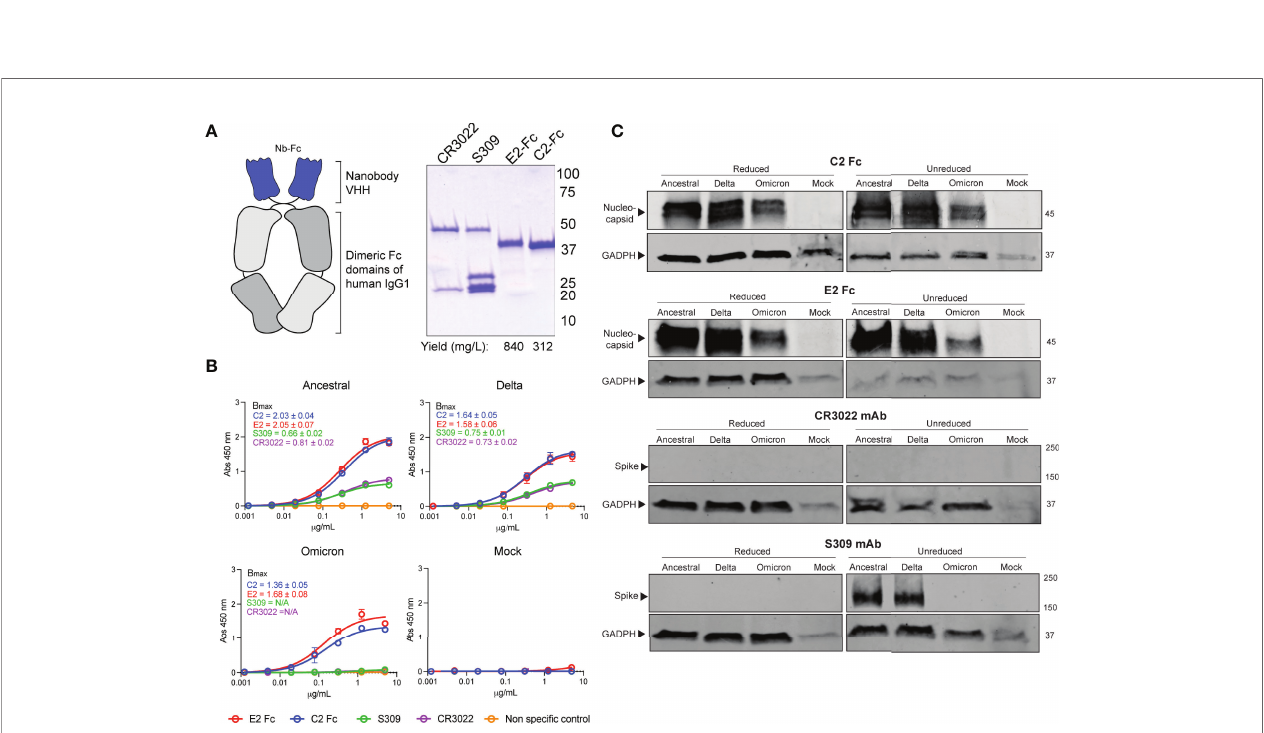
FIGURE 2 | Detection of SARS-CoV-2 variants by N-speci fi c nanobodies. (A) C2 and E2 nanobodies were formatted as dimeric Fc fusion proteins for ease of puri fi cation and detection. Coomassie stained SDS-PAGE shows highly pure products. (B) Differential detection of viral antigens in fi xed cell-based ELISA against infected Vero E6 cells. Assays were conducted twice with n = 2. Bmax values with standard error are shown for each variant as calculated by Prism Graphpad 9 software. (C) Detection of viral antigens in infected cell lysates in western blots ran under reducing (+DTT) or non-reducing conditions. Housekeeping protein GADPH was used as a positive control. Molecular weights are shown to the right in kDa.